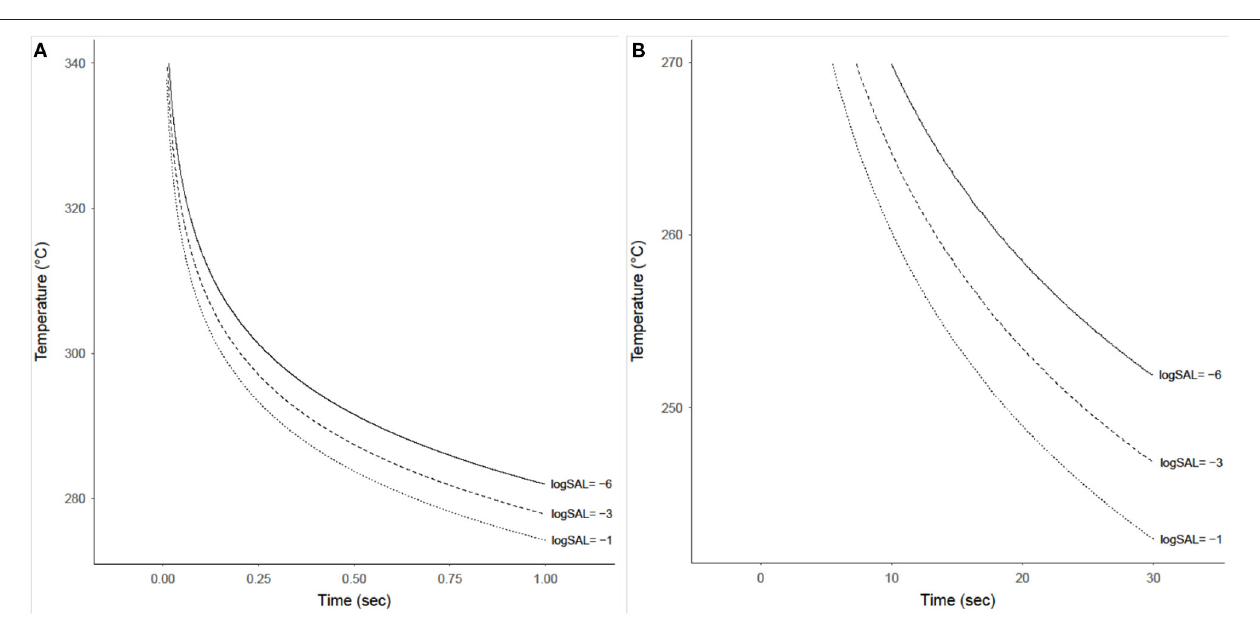
FIGURE 7 | Probability that a product with a bioburden of 1 × 10 6 is not sterile after being exposed to a given temperature (vertical axis) for a given time (horizontal axis). (A) Shows this probability for temperatures from 270 to 320 ◦ C and exposure times from 0.01 to 1 s, based on survival ratio and fraction-negative experiments and calculated using the expression on the left side of Equation (13). (B) Shows this probability for temperatures from 230 to 270 ◦ C for exposure times from 0.1 to 30 s, based on survival ratio experiments only and calculated using the expression on the left side of Equation (14).